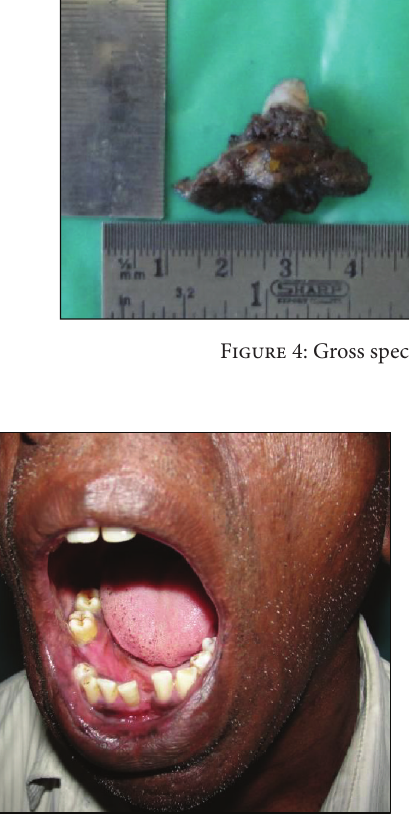
Figure 5: Clinical photograph of post-op intraoral choristoma.